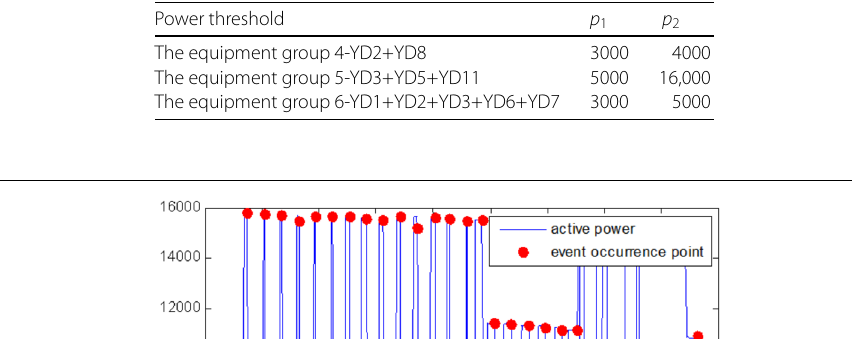
Table 1 Power threshold table